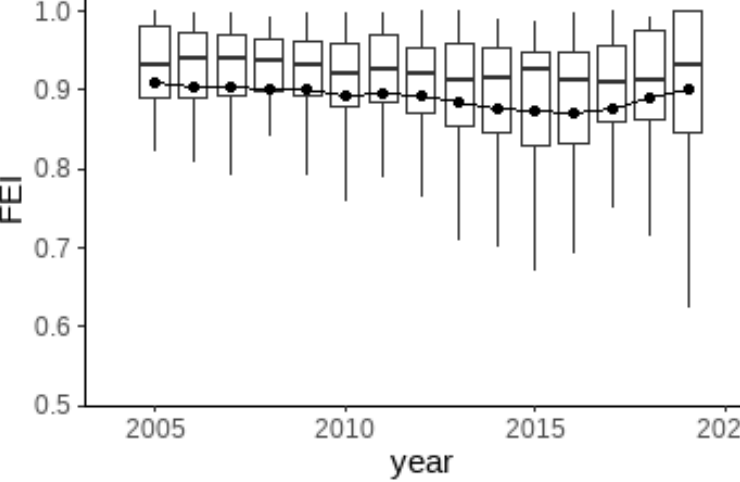
Figure 3. Trends in fertilizer use efficiency for grain production in China.